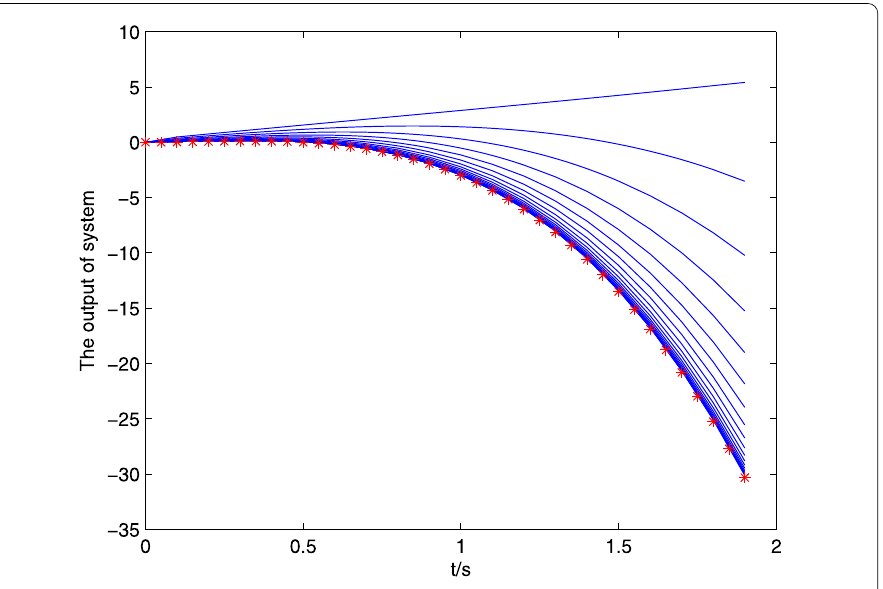
Figure 1 ∗∗∗ denotes the desired trajectory, — denotes the output of the